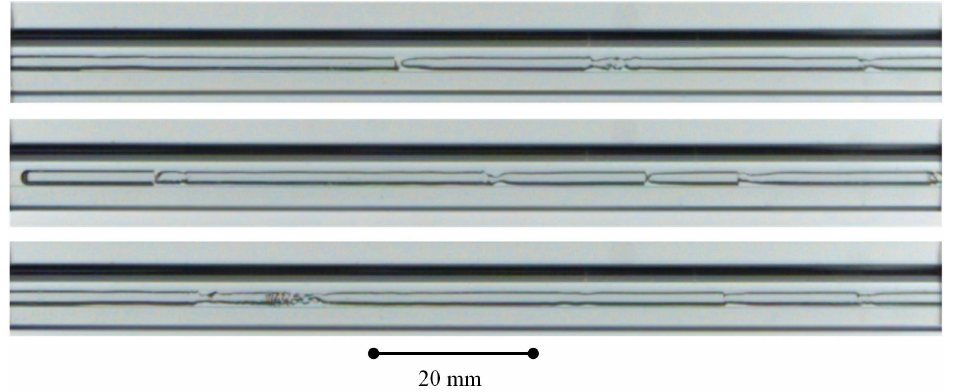
Figure 8. Merging of plug structures in the elongate bubble flow regime inside the PHP for the case of 100 W input power and ethanol as working fluid—52.6% filling ratio